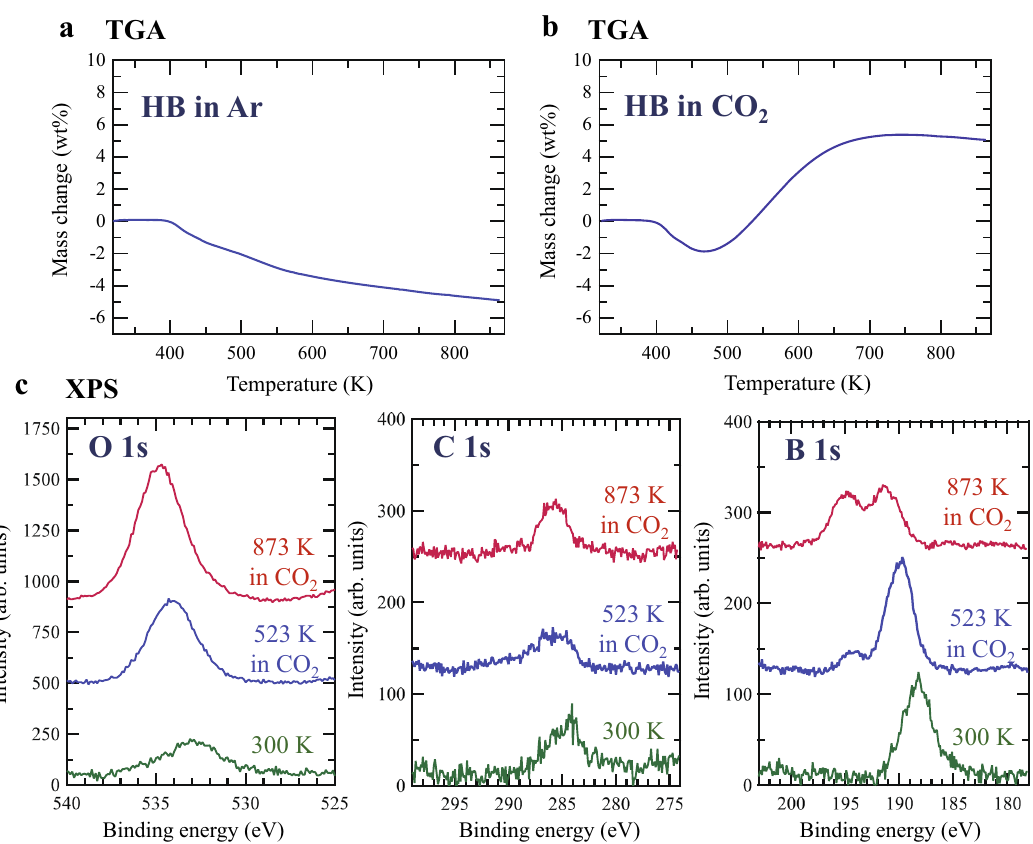
Fig. 5 Changes in hydrogen boride (HB) sheets upon heating under various reaction conditions. Thermogravimetric analysis (TGA) of the HB sheets in fl ows of a Ar and b CO 2 . c O 1s, C 1s, and B 1s XPS spectra of HB sheets at 300 K following heating at 523 K in CO 2 , and at 873 K in CO 2